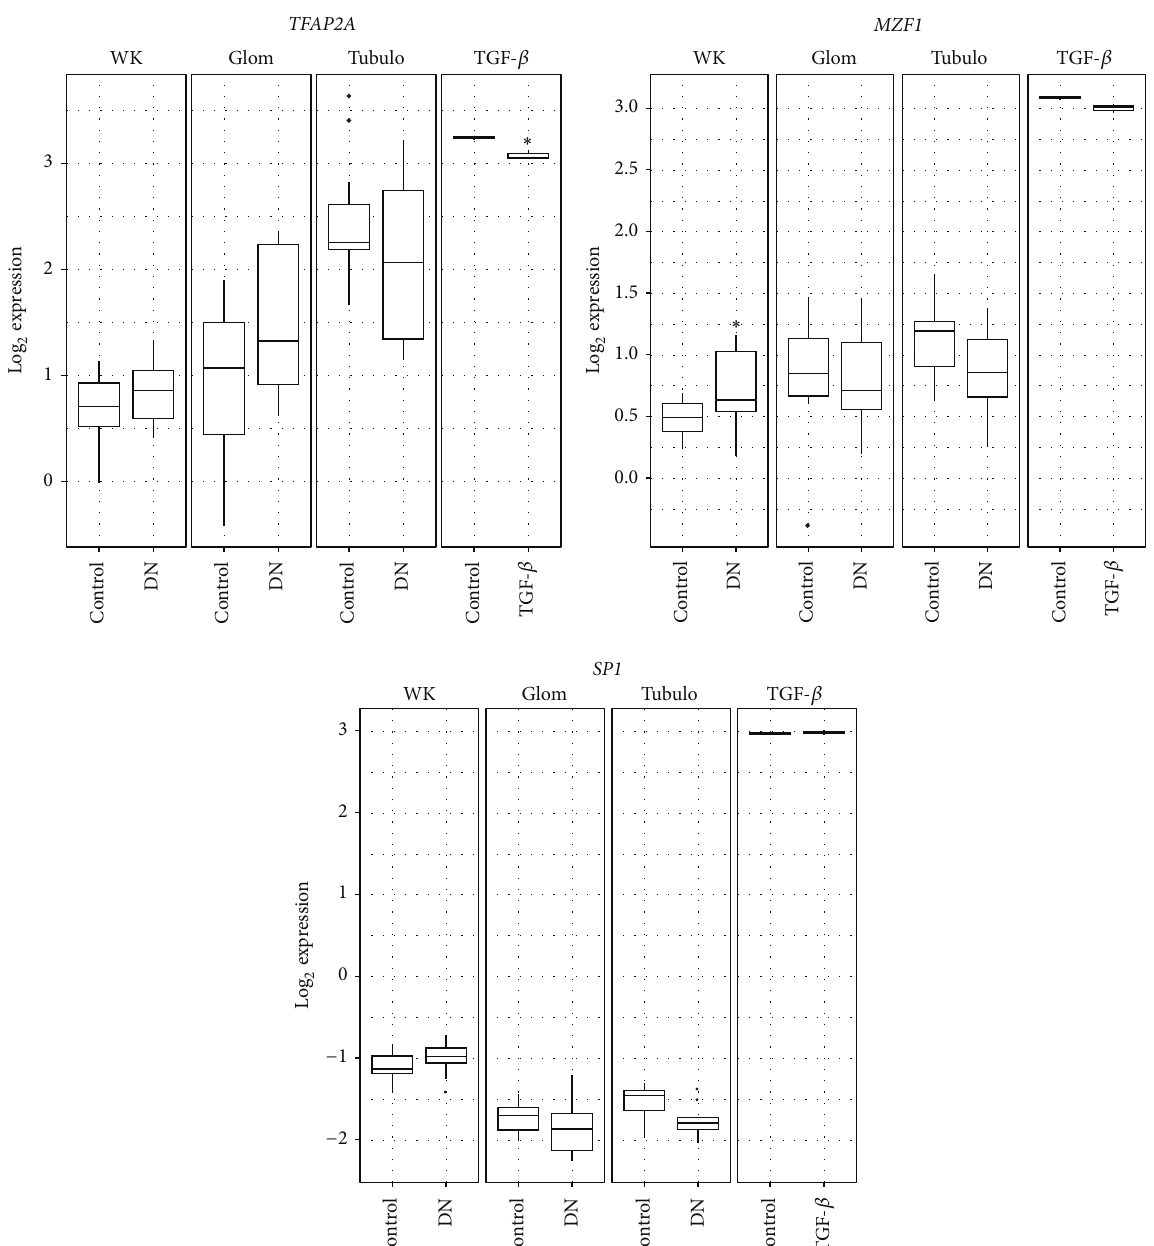
Figure 4: Expression of enriched transcription factors from four independent datasets. Log 2 expression values evaluated in Nephromine (http://www.nephromine.org) from whole kidney (WK [32]) biopsies, glomerulus (Glom [33]) biopsies, tubulointerstitium (Tubulo [33]) biopsies, and from HK-2 cells treated with TGF- 𝛽 for 48 hours (TGF- 𝛽 [34]). MZF1 gene expression was significantly increased in diabetic nephropathy (DN) whole kidney tissue compared to non-DN control (fold change = 1.16; 𝑃 = 0.031 ). TFAP2A gene expression was decreased in HK-2 cells treated with TGF- 𝛽 compared to untreated HK-2 cells ( − 1.02-fold change; 𝑃 = 0.031 ). correlated with MZF1 ( 𝑟 2 = 0.59 ; 𝑃 = 1.87 × 10 −7 ) and less so with SP1 ( 𝑟 2 = 0.46 ; 𝑃 = 1.09 × 10 −4 ). MZF1 was also significantly correlated with SP1 ( 𝑟 2 = 0.41 ; 𝑃 = 6.26 × 10 −4